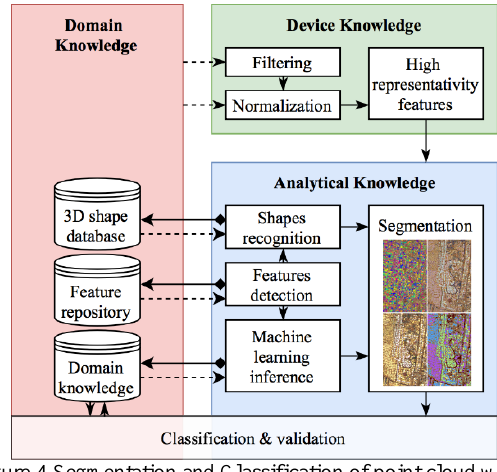
Figure 4 Segmentation and Classification of point cloud within a Smart Point Cloud (Poux et al., 2016a)